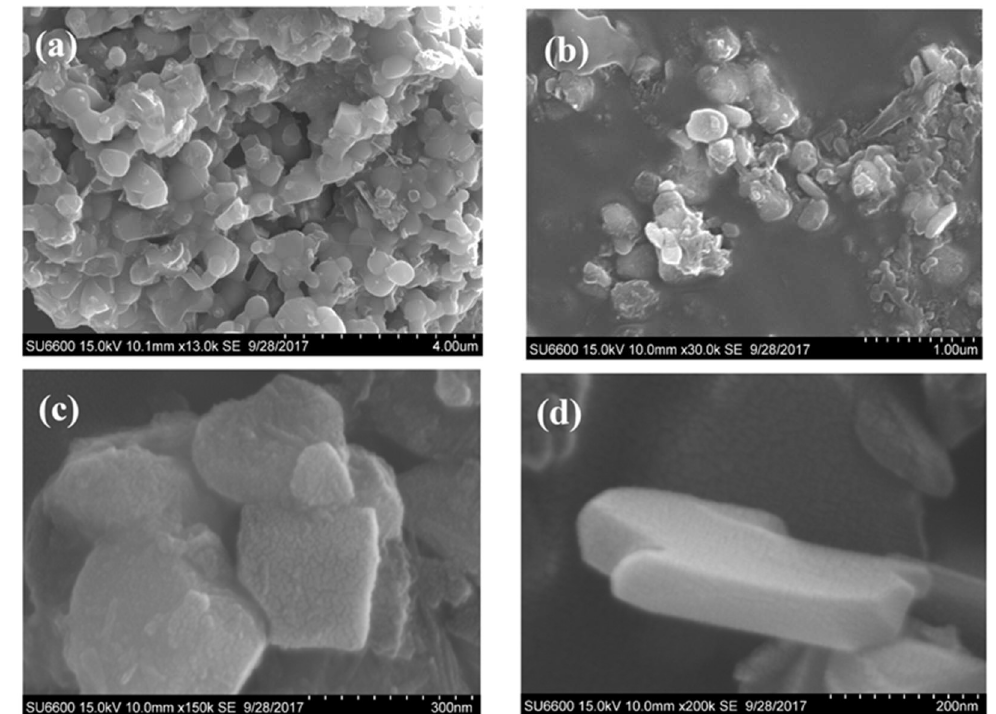
Figure 3. SEM images of hematite nanoparticles powder at ( a ) 4 µ m, ( b ) 1 µ m, ( c ) 300 nm, and ( d ) 200 nm magnifications, respectively.